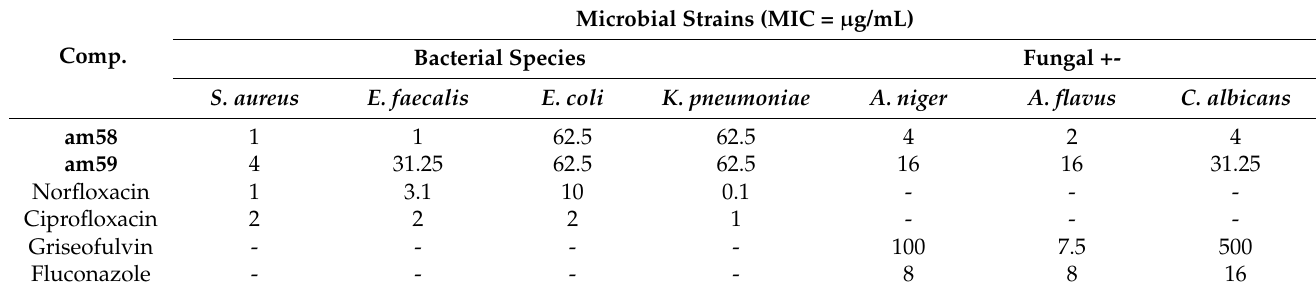
Table 27. Antimicrobial activity (MIC = µ g/mL) of the compounds ( am58 – am59 ).